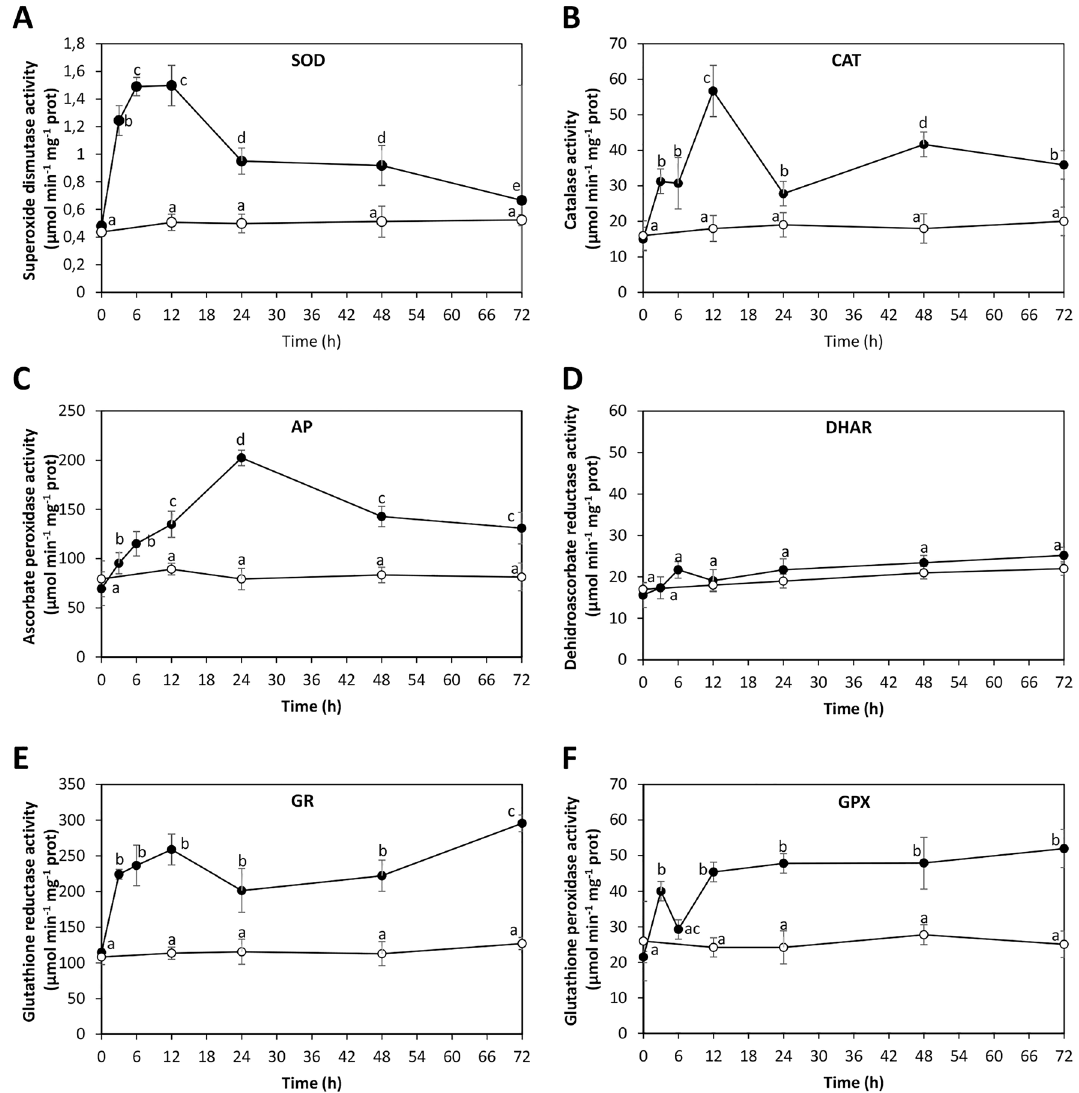
Figure 4. Activities of antioxidant enzymes superoxide dismutase ( A ), catalase ( B ), ascorbate peroxidase ( C ), dehydroascorbate reductase ( D ), glutathione reductase ( E ) and glutathione reductase ( F ) in U. lactuca cultivated without anthracene (open circles) and with 5 μM anthracene (black circles) for 0–72 h. Activities of antioxidant enzymes are expressed as micromole per minute per gram of fresh tissue (FT) and time in hours. Symbols represent mean values of three independent experiments ± SD. Letters indicate significant differences among experiments ( P <